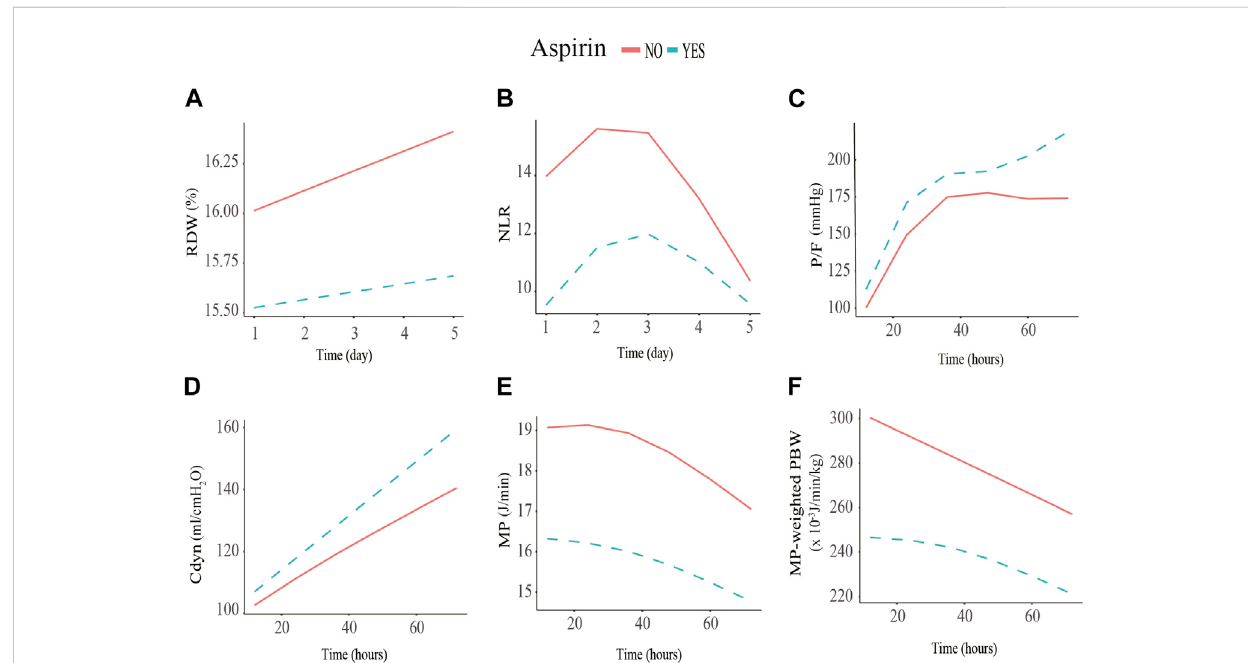
FIGURE 2 Associationbetweenredcelldistributionwidth(RDW),neutrophiltolymphocyteratio(NLR),P/Fratio,dynamiclungcompliance(Cdyn),mechanical power (MP), and MP normalized to predicted body weight (WMP) and low-dose aspirin exposure using the generalized additive mixed model. (A) initial RDW level of the pre-ICU low-dose aspirin exposure group is signi fi cantly lower than that of the non-exposure group ( − 0.60%, SE = 0.27, p = 0.027); (B) initialNLRlevel ofthelow-dose aspirinexposure groupissigni fi cantly lowerthanthat ofthenon-exposuregroup( − 3.83%,SE=1.43, p= 0.008); (C) P/F of the low-dose aspirin exposure group increased by 0.43 mmHg (SE = 0.24, p = 0.041) every hour compared to that of the non-exposure group within 72 h after receiving invasive mechanical ventilation; (D) Cdyn of the low-dose aspirin exposure group increased by 0.31mL/cmH 2 0 (SE = 0.21, p = 0.016) every hour compared to that of the non-exposure group within 72 h after receiving invasive mechanical ventilation; (E, F) MP ( − 2.80J/min, SE